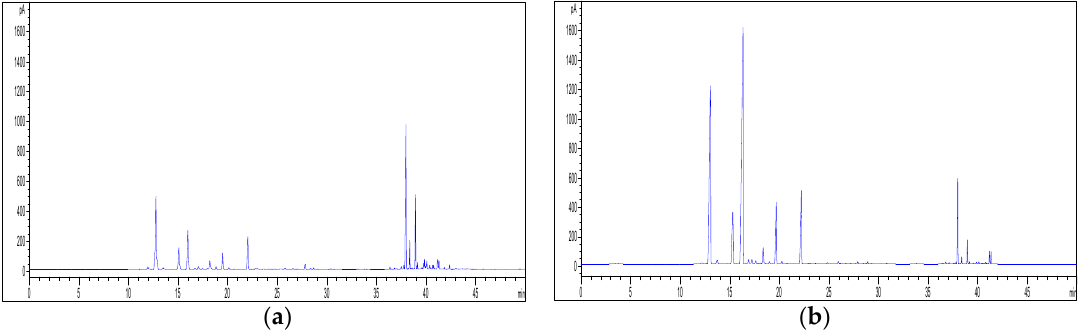
Figure 9. Effect of temperature on the HS-SPME-GC-FID profiles of hemp inflorescences (sample C3) with the DVB/CAR/PDMS fibre: ( a ) 40 °C; ( b ) 60 °C; ( c ) 80 °C.